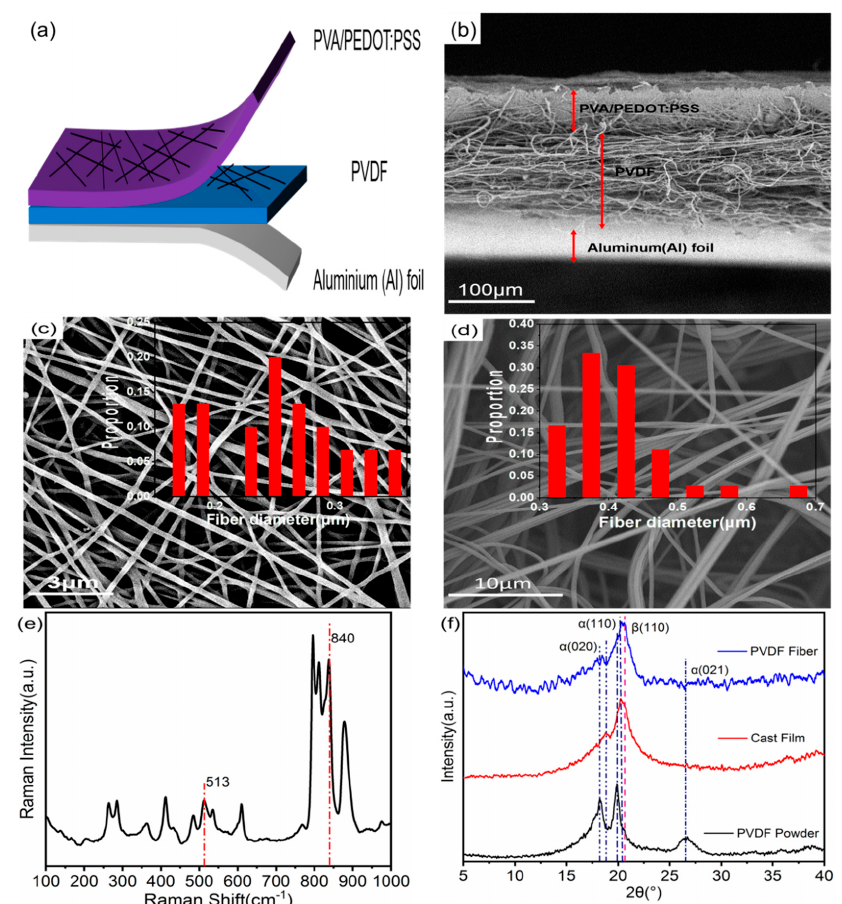
Figure 3. ( a ) Schematic diagram of nanogenerator structure. ( b ) Cross-section SEM image of the nanogenerator structure. ( c ) SEM images and bar charts (insets) of the fiber size distributions of the PVA/PEDOT:PSS CNCFM and ( d ) SBS pure PVDF nanofiber membrane. ( e ) Raman spectra of the SBS pure PVDF nanofiber membrane. ( f ) XRD patterns of PVDF powder, PVDF cast film and SBS nanofibers.